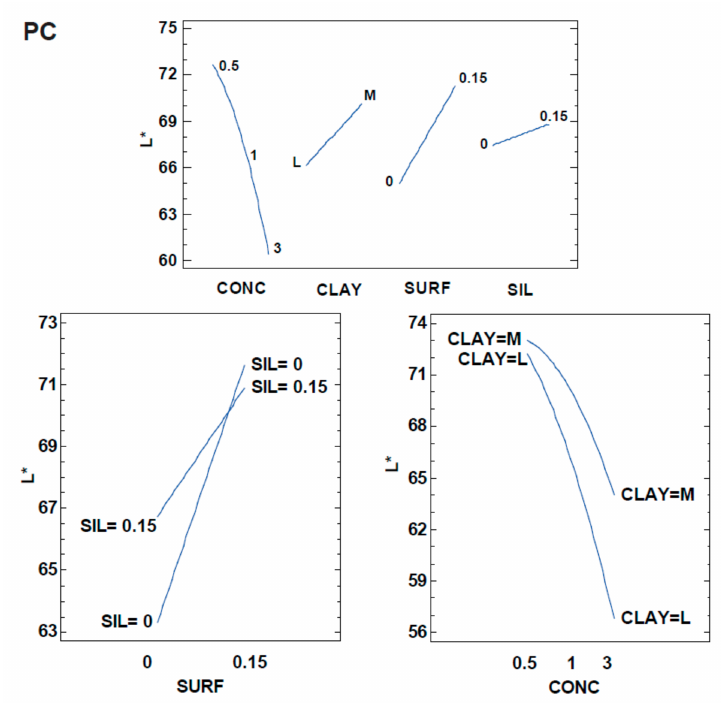
Figure 7. Main effects and interactions plots from the L* response in the PC pigments.